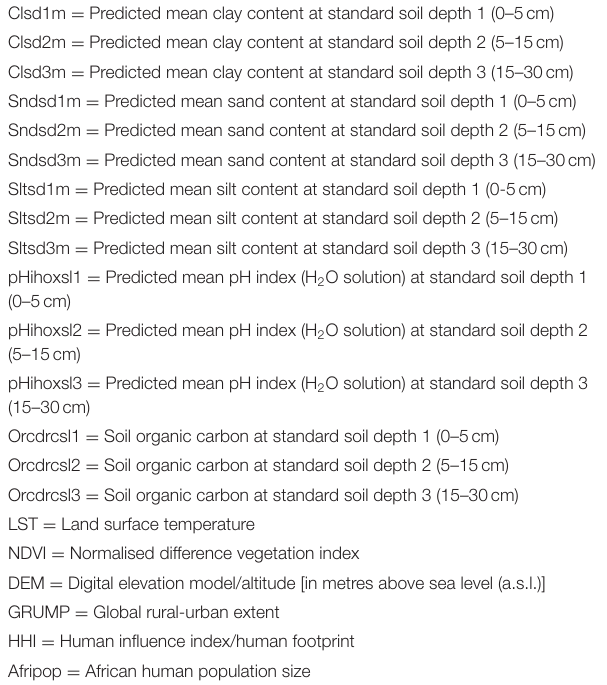
TABLE 1 | A list of environmental variables used to build ecological niche models of rodent-borne cestodes in Gauteng Province, South Africa. Clsd1m = Predicted mean clay content at standard soil depth 1 (0–5cm) Clsd2m = Predicted mean clay content at standard soil depth 2 (5–15cm) Clsd3m = Predicted mean clay content at standard soil depth 3 (15–30cm) Sndsd1m = Predicted mean sand content at standard soil depth 1 (0–5cm) Sndsd2m = Predicted mean sand content at standard soil depth 2 (5–15cm) Sndsd3m = Predicted mean sand content at standard soil depth 3 (15–30cm) Sltsd1m = Predicted mean silt content at standard soil depth 1 (0-5cm) Sltsd2m = Predicted mean silt content at standard soil depth 2 (5–15cm) Sltsd3m = Predicted mean silt content at standard soil depth 3 (15–30cm) pHihoxsl1 = Predicted mean pH index (H 2 O solution) at standard soil depth 1 (0–5cm)